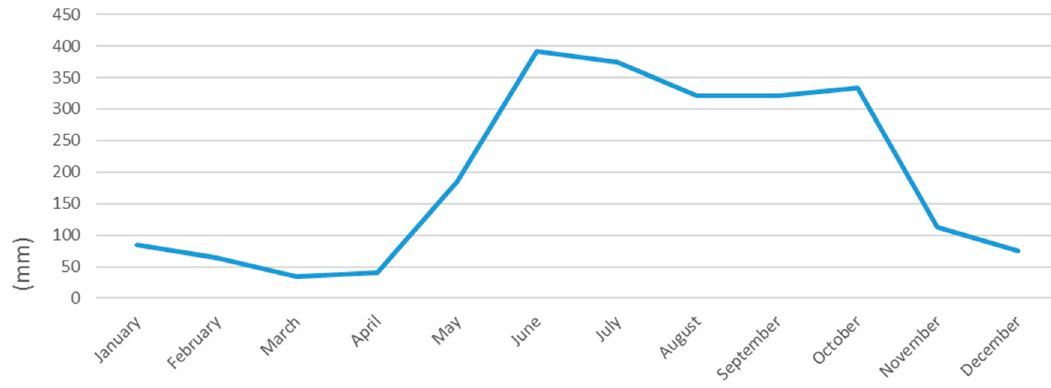
Figure 2. Average monthly precipitation in the study area 2007–2015.